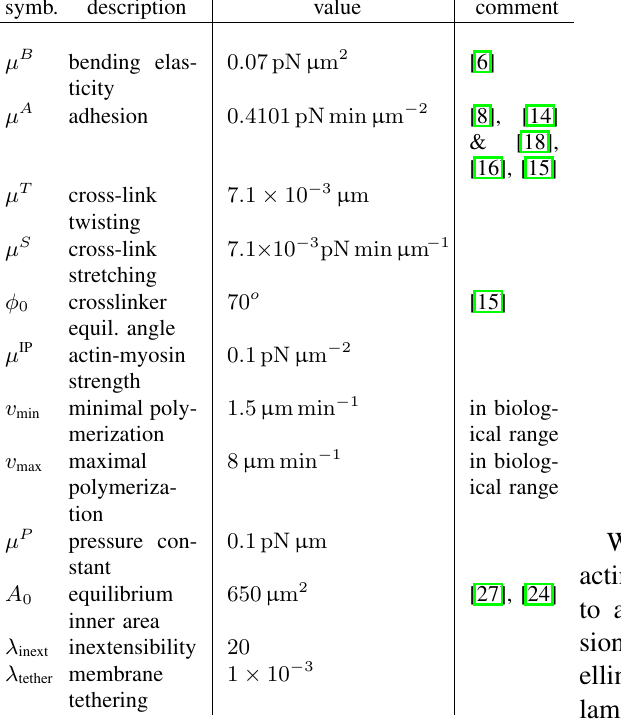
B ASIC SET OF PARAMETER VALUES USED IN THE NUMERICAL SIMULATIONS OF THE FBLM IN ALL THE EXPERIMENT OF THIS WORK . T HESE PARAMETERS HAVE BEEN ADOPTED FROM [11], [23]. symb.